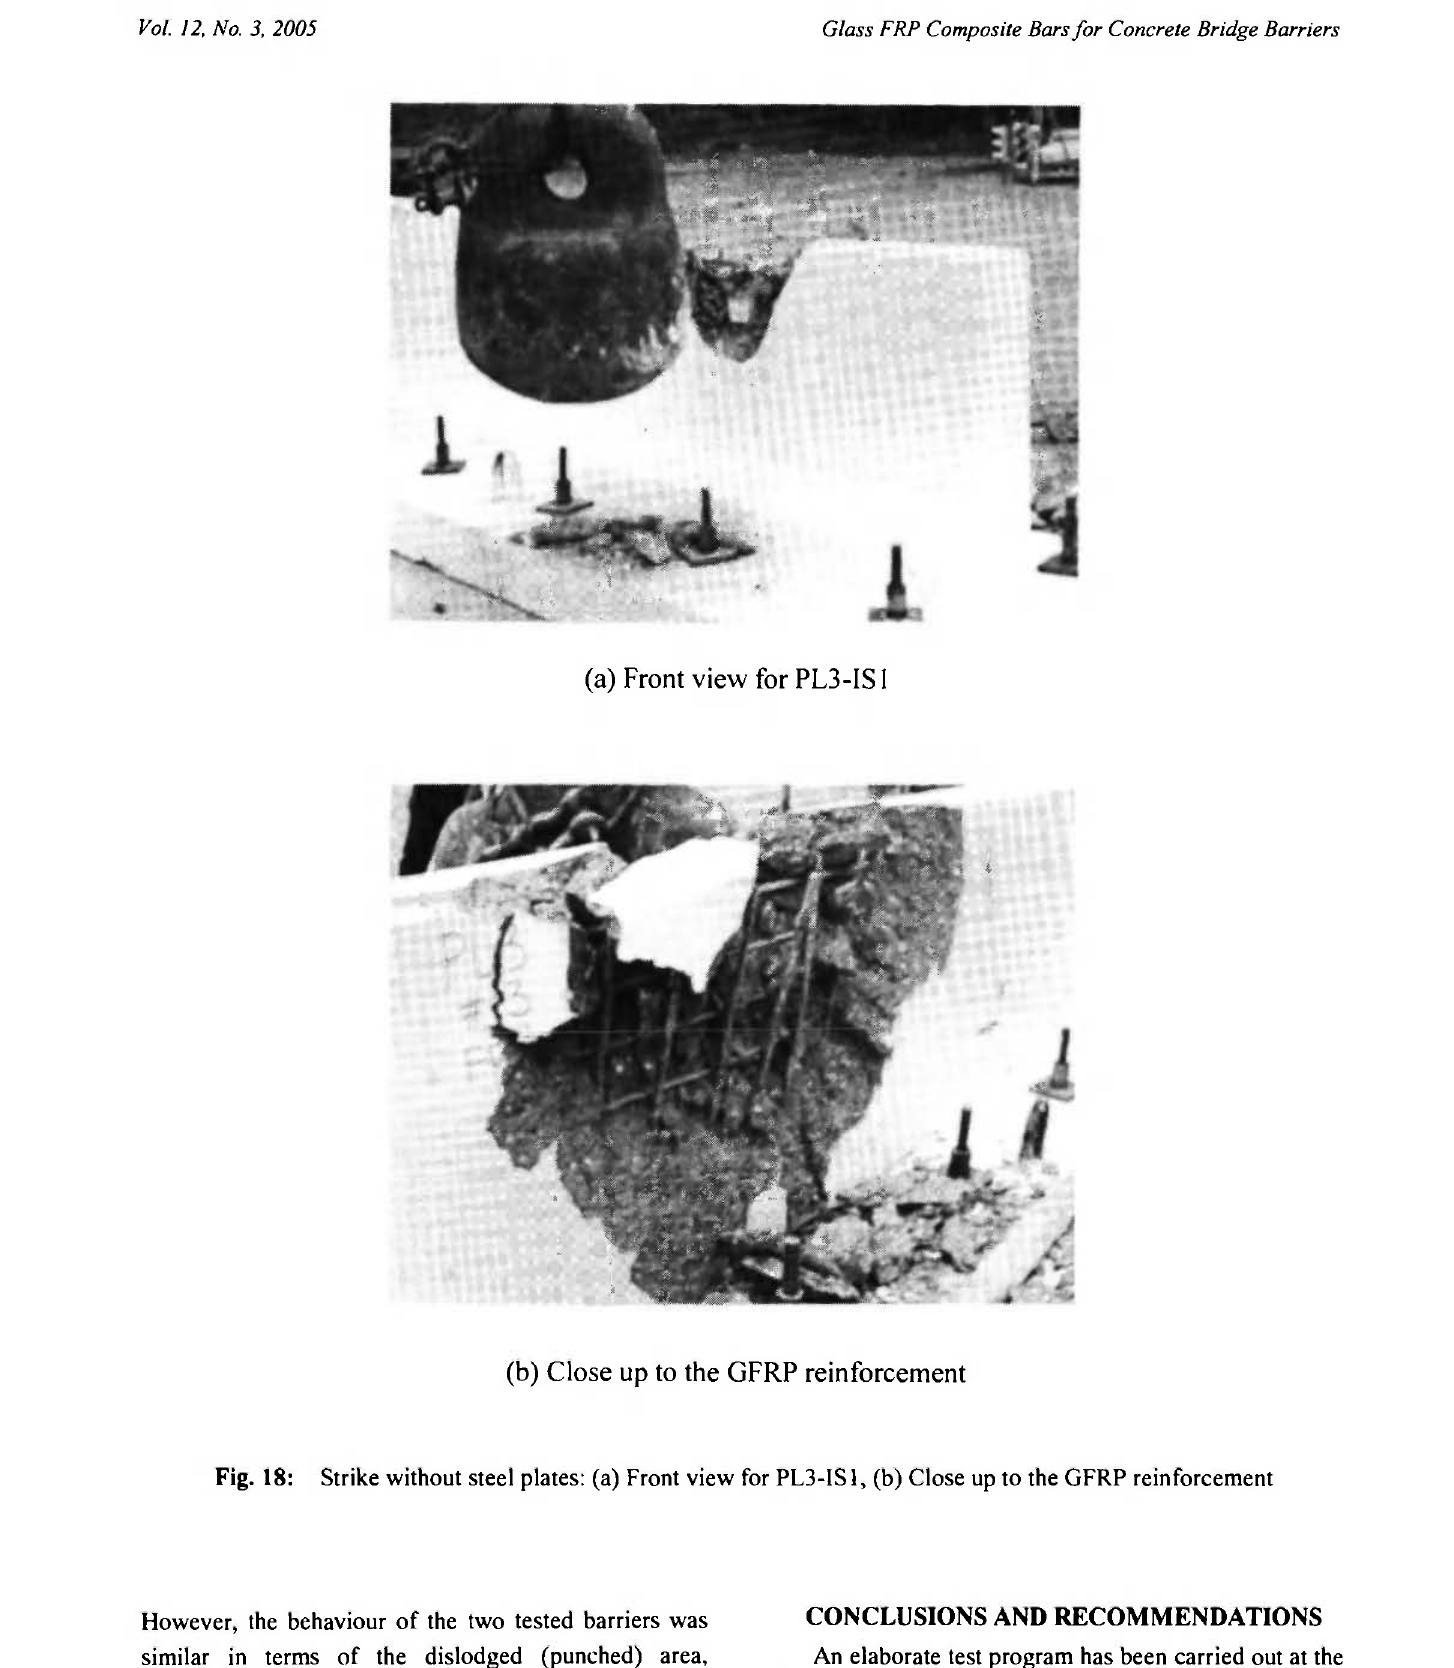
Fig. 18: Strike without steel plates: (a) Front view for PL3-IS1, (b) Close up to the GFRP